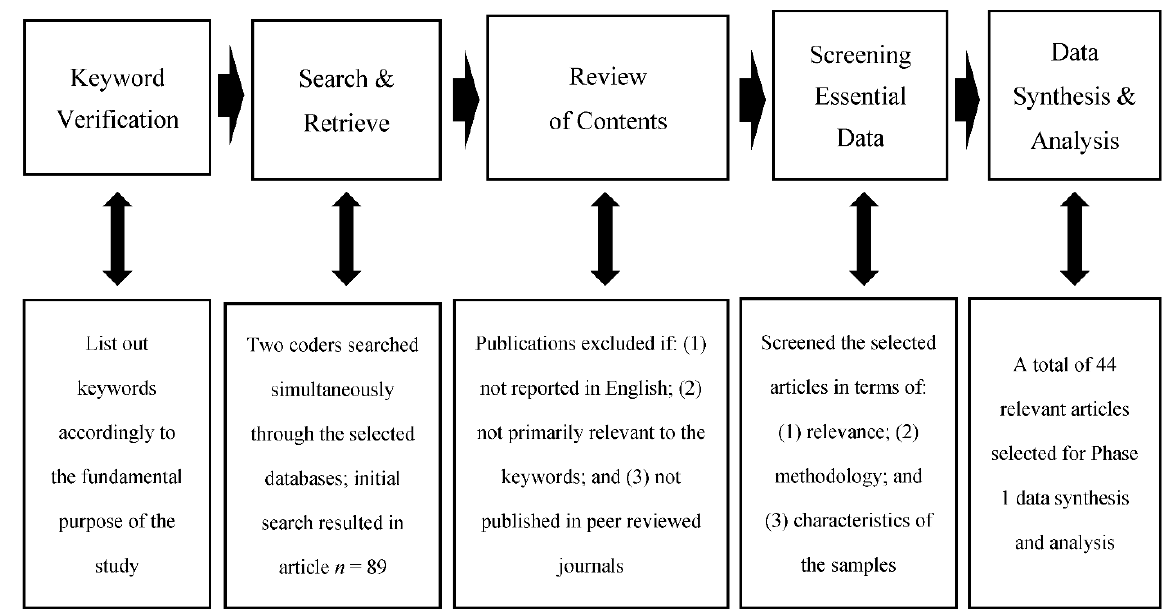
Figure 1. Procedural details of text data coding and analysis.